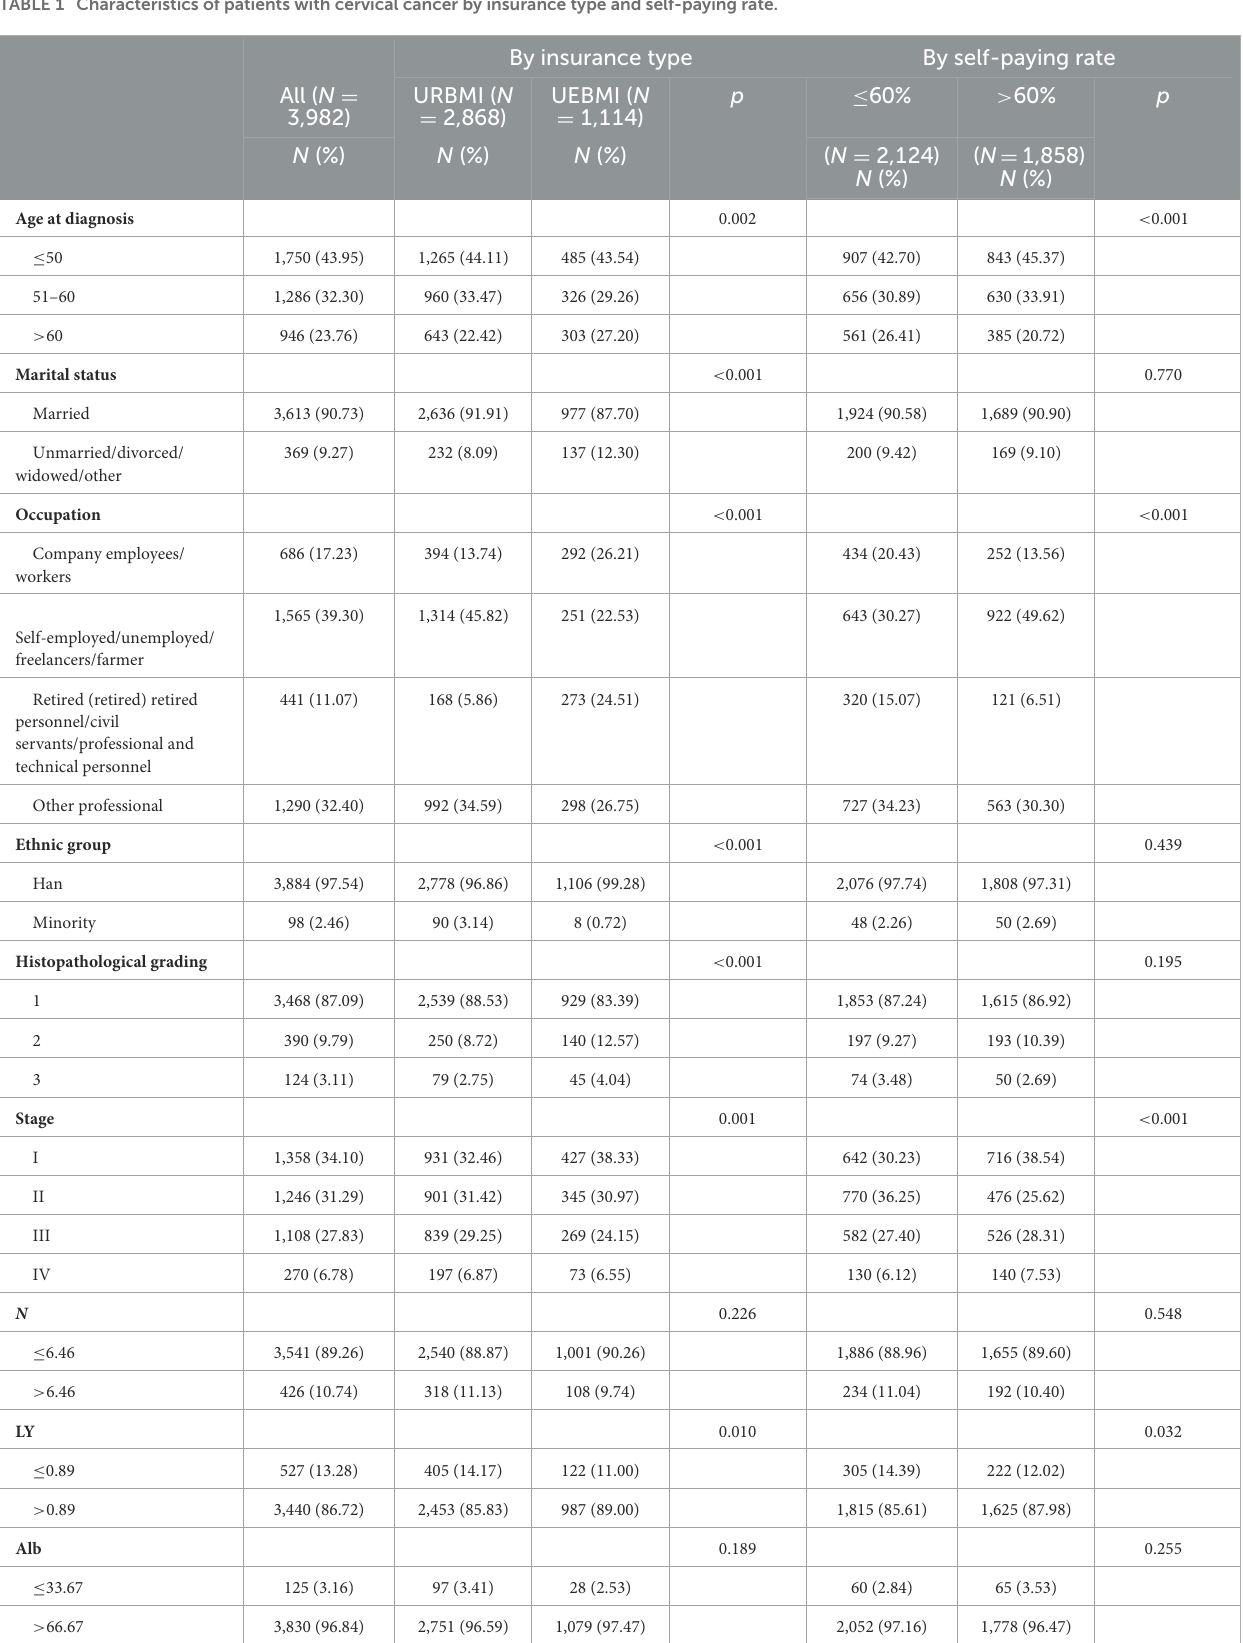
TABLE 1 Characteristics of patients with cervical cancer by insurance type and self-paying rate.